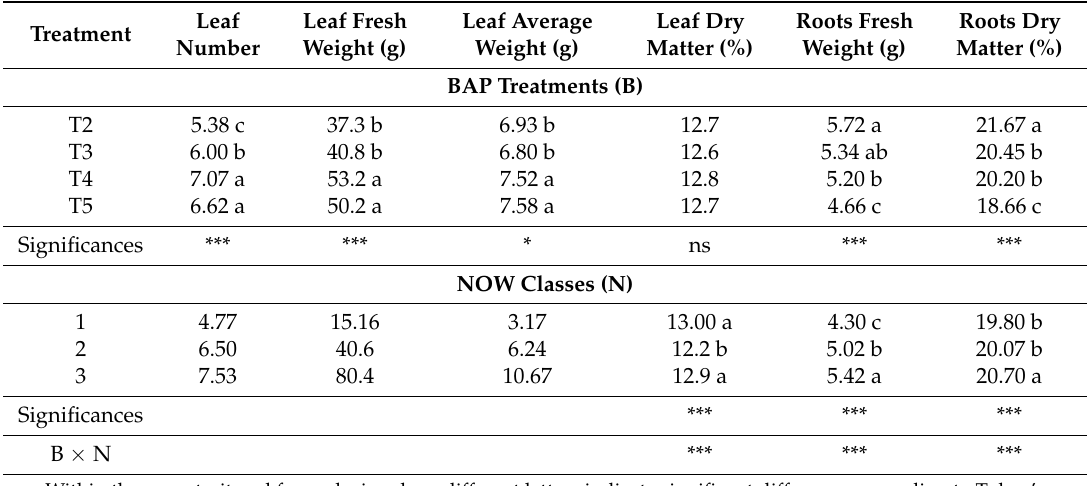
purine (BAP) treatment and to their size classes (NOW).